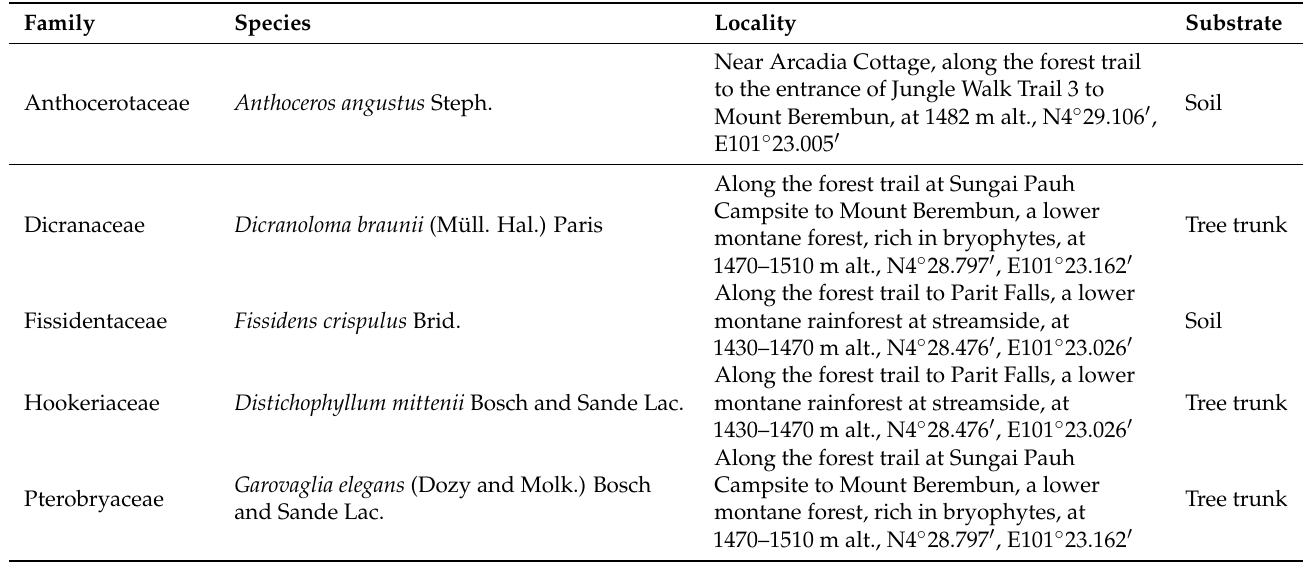
Table 1. Bryophyte species from Cameron Highlands with information on the family and species name, collecting locality and